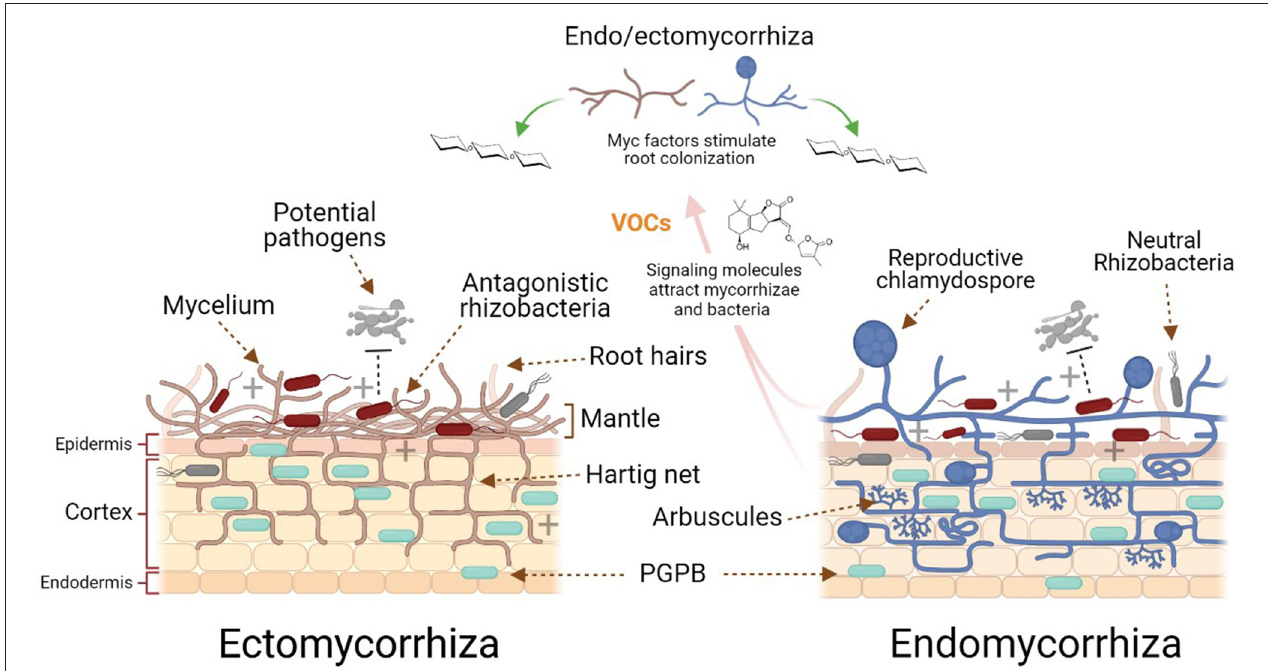
FIGURE 1 | Schematic illustration of the endo- and ectomycorrhizal general differences and interactions in the rhizosphere. Plant strigolactones and volatile compounds attract beneficial ecto- and endomycorrhiza and plant growth-promoting bacteria (PGPB). Ectomycorrhizae form an external mantle, while endomycorrhizae mainly penetrate between the cells of the root epidermis to generate a Hartig net mycorrhizae and auxin-like compounds produced by the mycorrhizae to stimulate pre-colonization of the plant